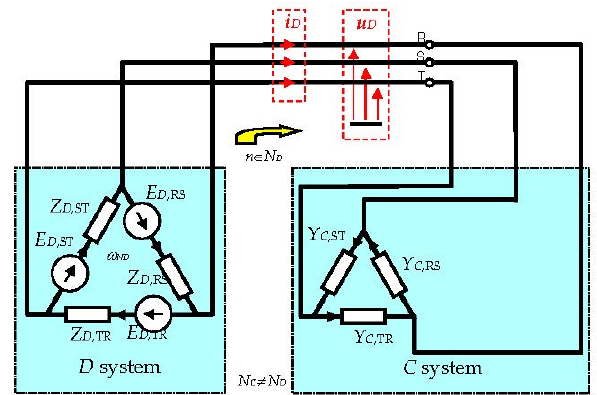
Figure 6. Cooperation of a non-linear three-phase receiver with a real source in the absence of the same harmonics in E D and J C sources. Energy flow from D to C system.